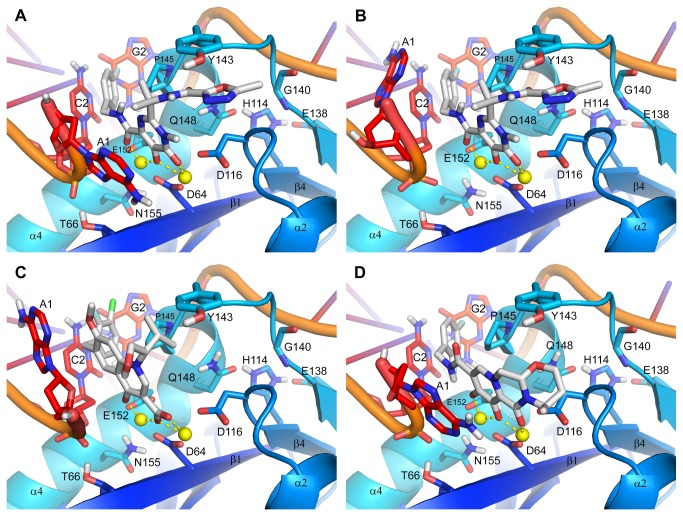
Structural models of HIV-1 integrase with U5 LTR DNA and (A, B) raltegravir, (C) elvitegravir or (D) dolutegravir.For raltegravir, the terminal 3′ adenylate is depicted in 2 distinct conformations: panel 2A shows the published conformer and panel 2B shows an alternative conformer that is also consistent with the observed electron density. Raltegravir, elvitegravir and dolutegravir are in stick representation with carbon, nitrogen, oxygen, fluorine and chlorine atoms colored gray, blue, red, cyan and green, respectively. A select subset of amino acids and nucleotides is depicted and labeled with residue type and number (numbering schemes as listed in Figure S1); all residues are in stick representation with carbon atoms colored by secondary structure/chain and nitrogen and oxygen atoms colored blue and red, respectively. The Mg2+ ions are represented as small yellow spheres with coordinate bonds to the inhibitors depicted as dashed yellow lines.